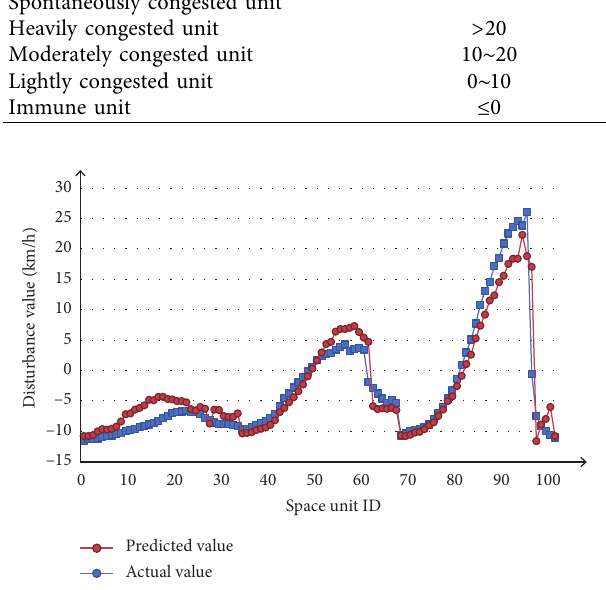
Figure 3: Comparison between the predicted value curve and actual observed value